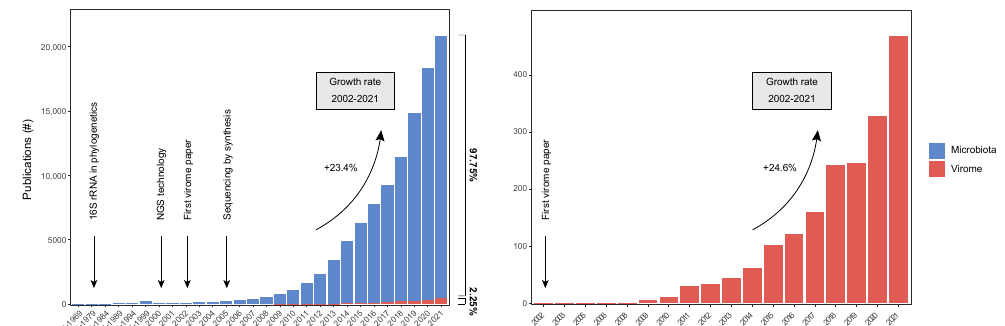
Figure 1. Number of publications in microbiome and virome research. Number of publications were determined by querying the search term “Microbiome [TITLE/ABSTRACT]” and “Virome [TI-